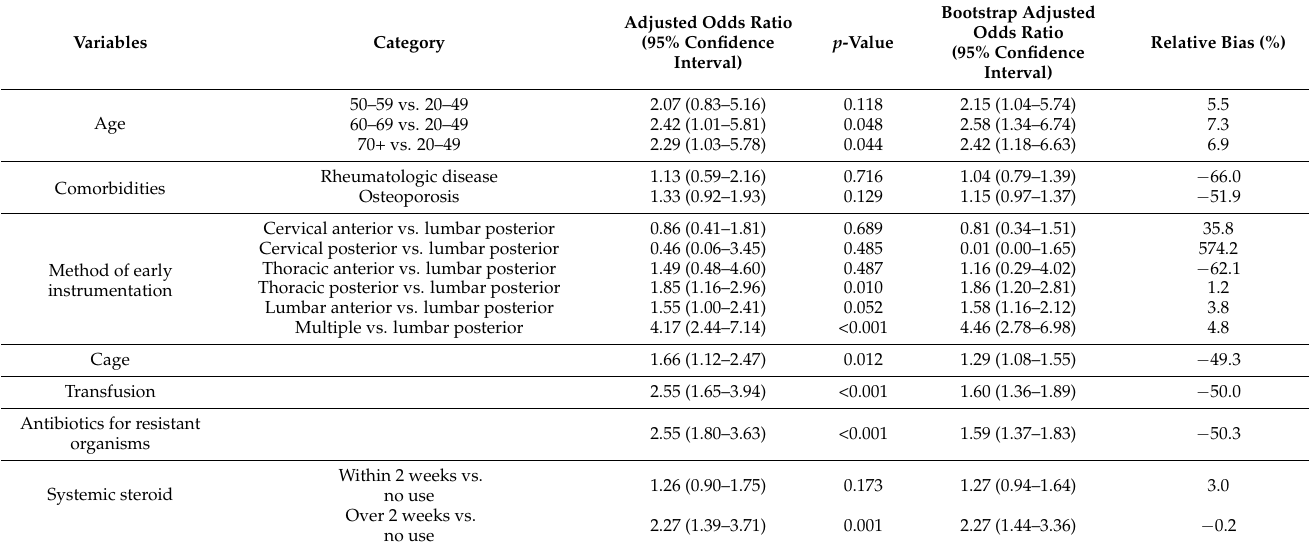
Table 5. Factors associated with recurrence: multivariable analysis with bootstrap